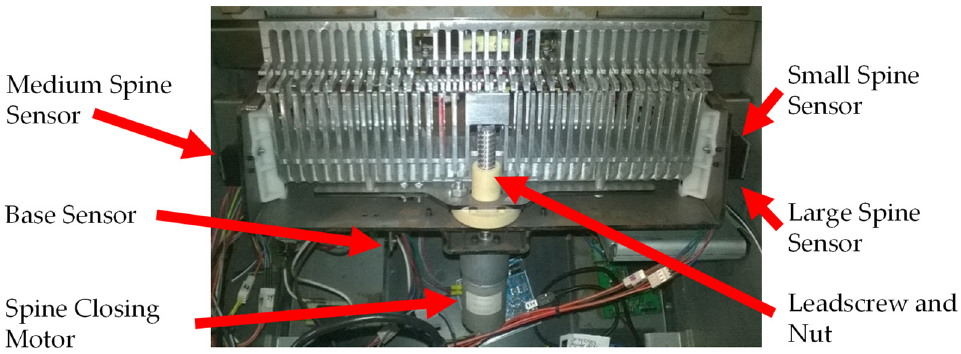
Figure 9. The spine closing mechanism indicating the sensors used for closing spines of each size.